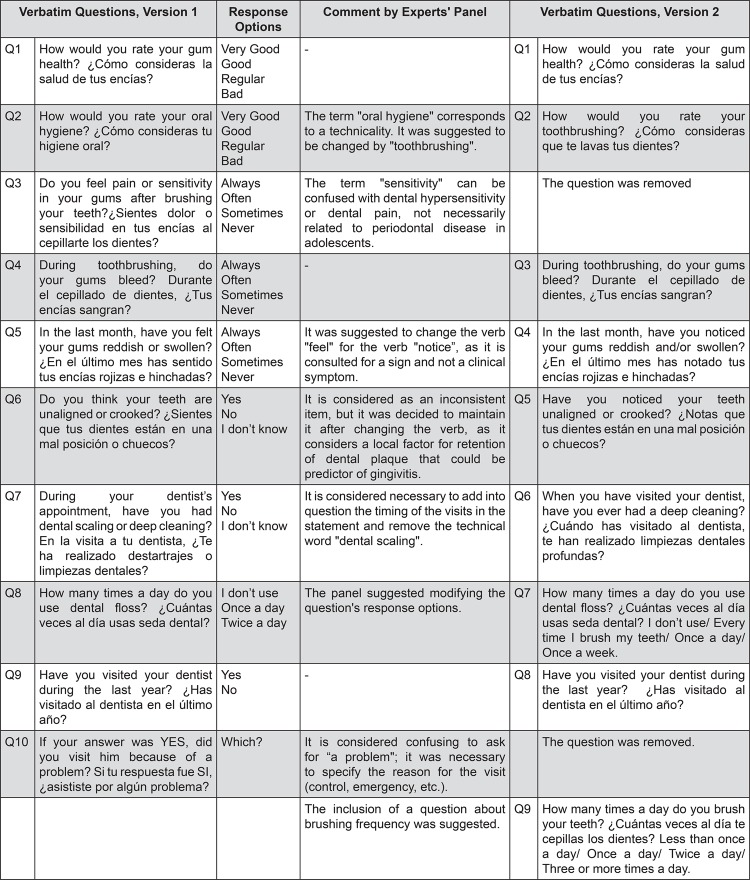
Questionnaire version 1 and version 2 in English and Spanish